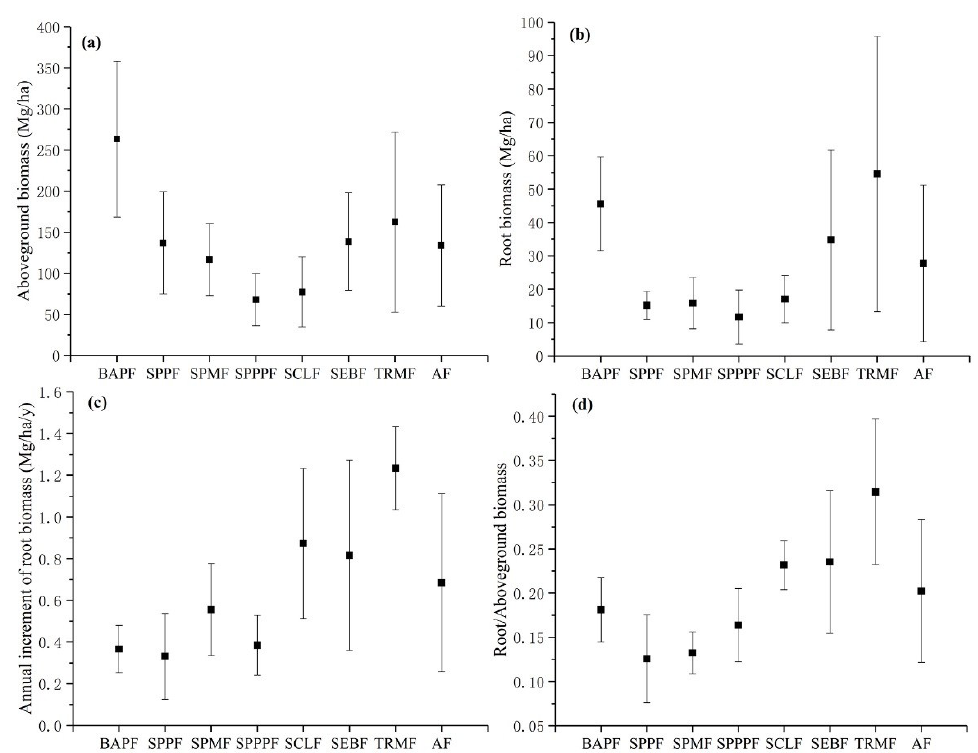
Figure 2. Mean values ± SE of ( a ) aboveground biomass per ha (AB, Mg/ha); ( b ) forest root biomass per ha (RB, Mg/ha); ( c ) annual increment of root biomass per ha (AIRB, Mg/ha/year); and ( d ) ratio of root biomass per ha and aboveground biomass per ha (RRA) in southwest China. AF: all forest types. Table 1. Pearson correlations between forest root biomass per ha (RB, Mg/ha), annual growth increment of root biomass per ha (AIRB, Mg/ha/year), ratio of root biomass per ha and aboveground biomass per ha (RRA) and site conditions, for forests stands in southwest China. Site Conditions RB (Mg/ha) AIRB (Mg/ha/year) RRA Longitude (E, ◦ C) − 0.227 ** 0.277 ** − 0.011 Latitude (N, ◦ C) Altitude (m) 0.008 Note: * and ** indicate p < 0.05 and p < 0.01